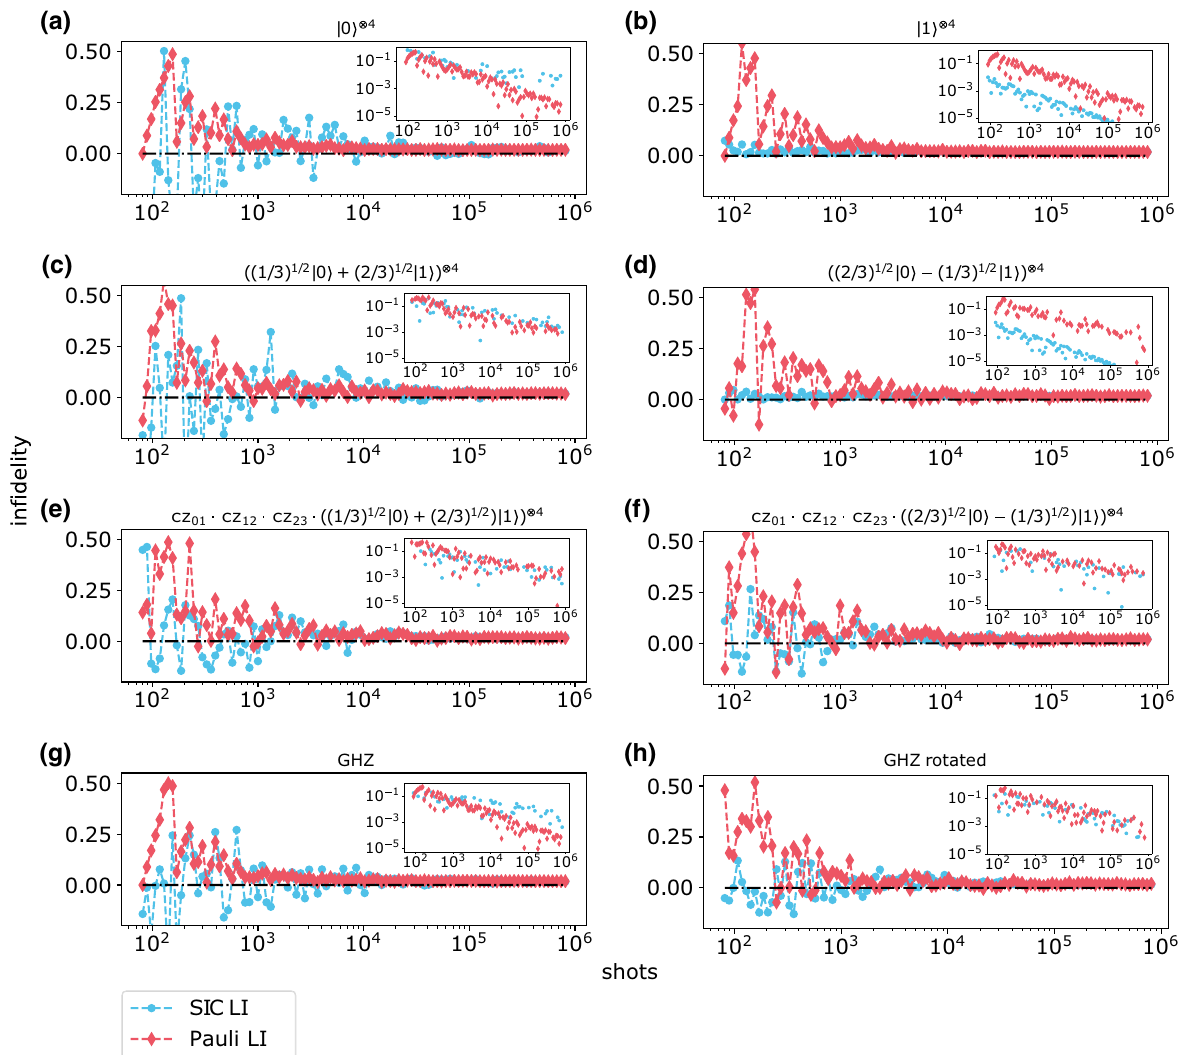
FIG. 14. Convergence of SIC and Pauli tomography in numerical simulations for noisy states with different basis overlap. To incor- porate noise, a depolarizing channel is applied to the ideal density matrices; see the text for details. Complementary, insets represent numerical results on projection noise only to more distinctively illustrate convergence behavior. (a)–(d) Local states that align with a SIC vector (a),(c) show slower convergence for SIC tomography than those orthogonal to a SIC vector (b),(d), confirming the experi- mental observations of Fig. 13. Pauli tomography, on the other hand, generally performs best for states aligned with the basis (a),(b). (e)–(h) The differences in convergence performance vanish for SIC tomography when considering entangled states. In the case of the Pauli basis, however, some improved convergence can still be observed for specific states, such as the GHZ state (g), which is aligned with the Pauli basis and thus performs better. Overall, the fast converging situations (more pronounced in the insets) for SIC (b),(d) and Pauli (a),(b),(g) tomography do beyond a certain shot number that depends on the noise, no longer carry unphysical components in the resulting